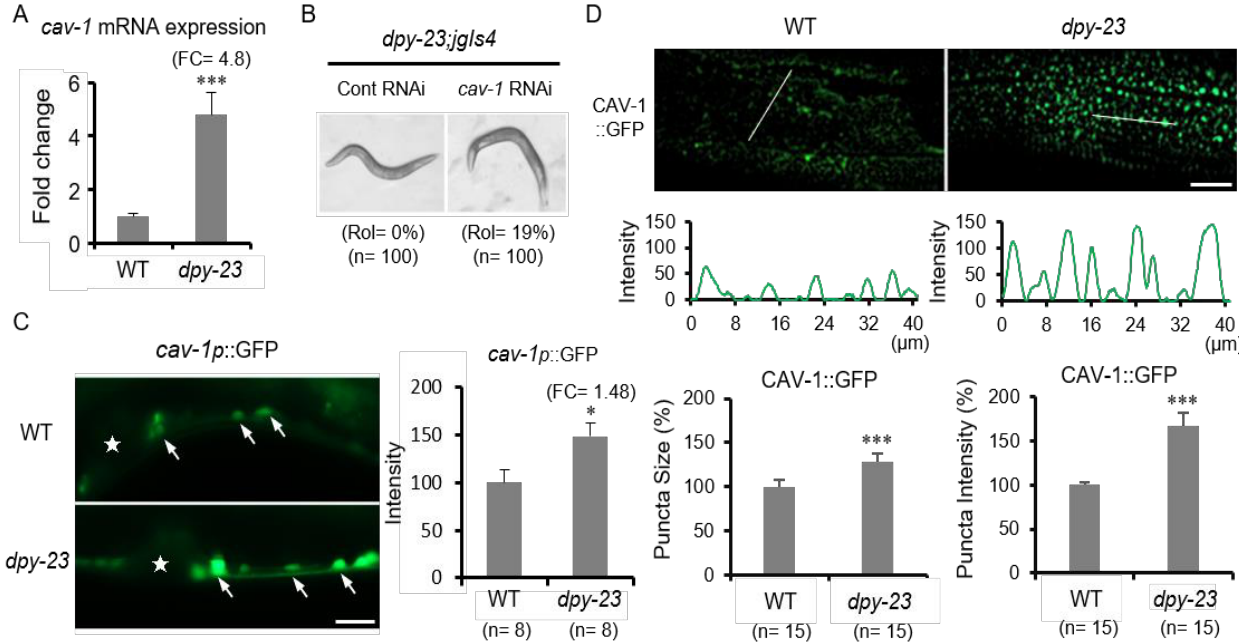
Figure 3. Increase of cav‐1 expression in the dpy‐23 mutant. ( A ) The mRNA expression of cav‐1 gene in the dpy‐23 mutant was compared to the wild type using a quantitative reverse transcription PCR (qRT‐PCR). Error bar = SD. FC = fold change. ( B ) The dpy‐23; jgIs4 strain was treated with cav‐1 RNAi to investigate its effect on cuticle formation. ( C ) The GFP reporter expressed by the cav‐1 promoter ( cav‐1p ::GFP) was observed in wild type and dpy‐23 to investigate cav‐1 transcription in vivo. Because cav‐1p ::GFP expression was more visible in neurons than in other tissues, cav‐1p ::GFP expression in ventral neurons was compared. Asterisks indicate vulvae, and arrows indicate the cell bodies of ventral neurons. Scale bar = 20 μm. The measured GFP intensity is shown in the graph on the right. Error bar = SEM. ( D ) CAV‐1::GFP expressed in the hypodermis by Y37A1B.5 p was observed and compared (upper panel). CAV‐1::GFP intensity was measured along thin white lines in wild type and dpy‐23 (middle panel). The measured puncta size and intensity of CAV‐1::GFP are shown in the graph (bottom panel). Scale bar = 20 μm. Error bar = SEM. * p < 0.05 and *** p < 0.001 versus WT.